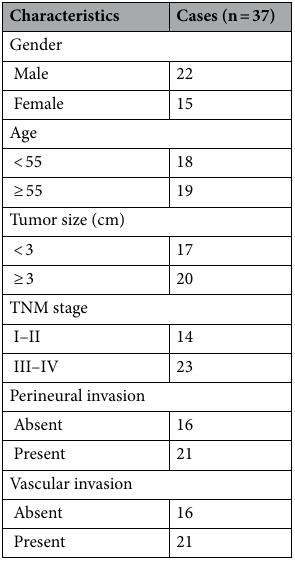
Table 1. The clinical characteristics of 37 patients with